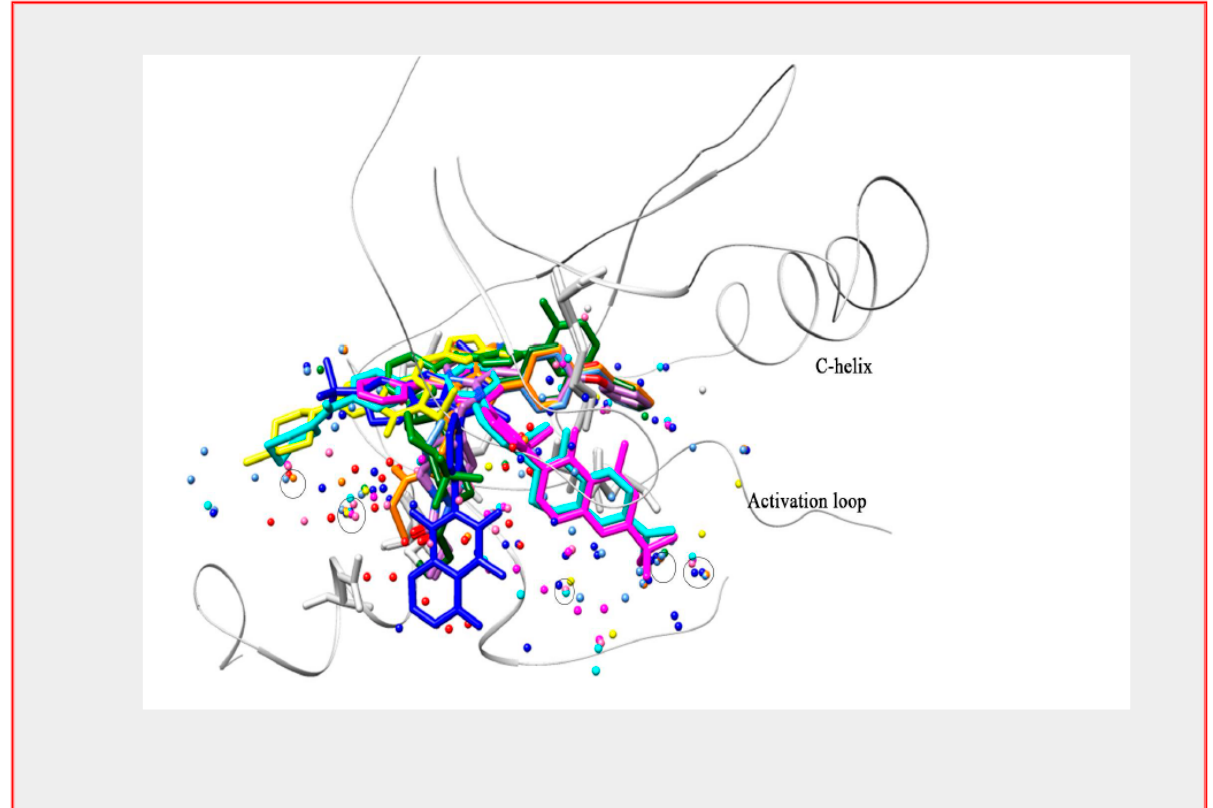
Figure 6. BTK and its interaction with reversible and irreversible inhibitors. Ten different reversible inhibitors (PDB: 3GEN, 3K54, 3PIX, 3PIZ, 4RFY, 4Z3V, 5KUP, 5T18) and irreversible inhibitors (PDB: 5P9J, 6J6M, 6OMU, 6N9P) are shown bound to a superimposed crystal structure of the BTK kinase domain. The figure focuses on the conserved (circled) and invariant water molecules at the active site.